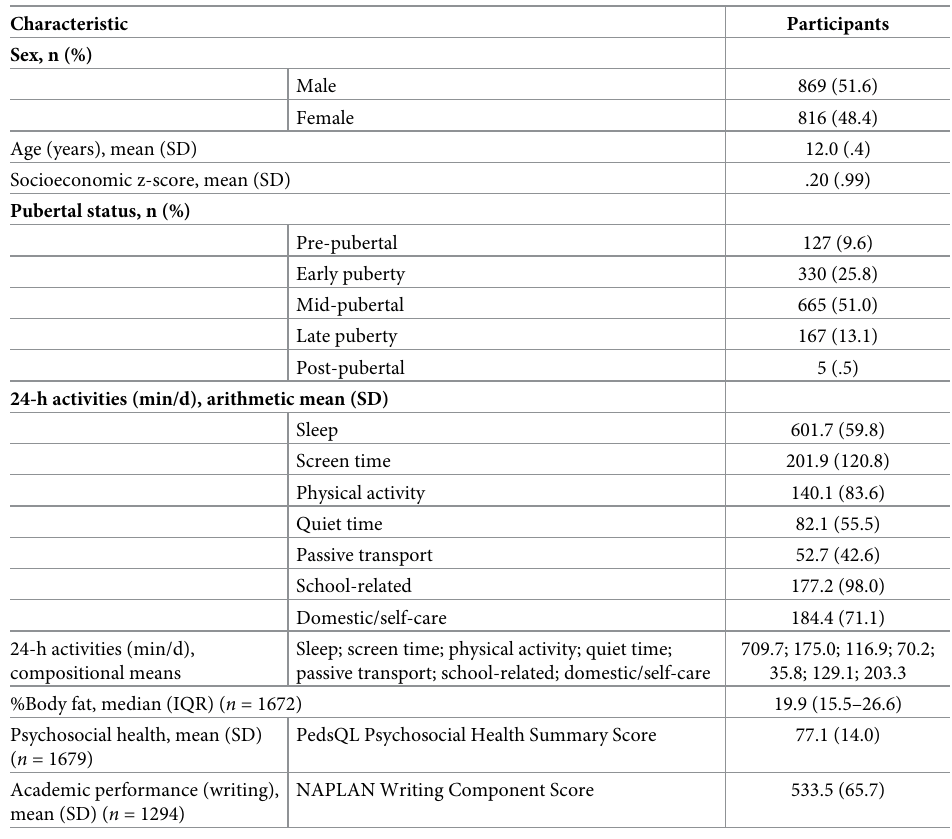
Table 1. Sample characteristics ( n =